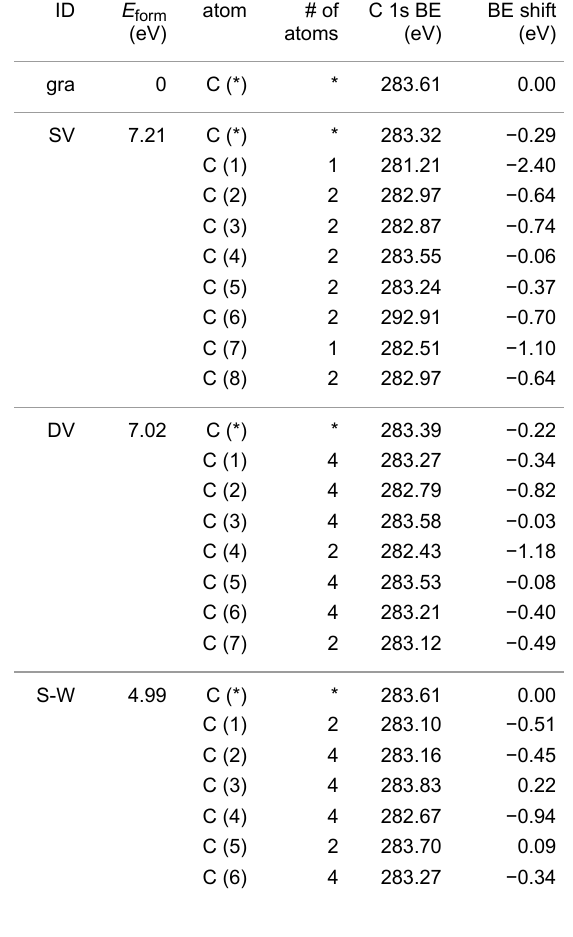
Table 1: Calculation results for the pristine and defected graphene structures. The columns show: system identifier; formation energy of the defect; target atom of the calculation (see Figure 1); number of target atoms; calculated 1s binding energy; C 1s BE shift with respect to the calculated C 1s energy of pristine graphene.